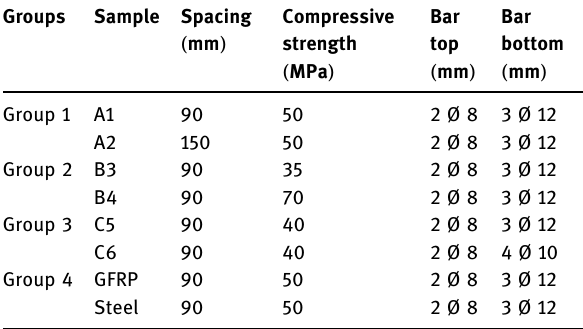
Table 1: The speci fi cs of modeling beams Groups